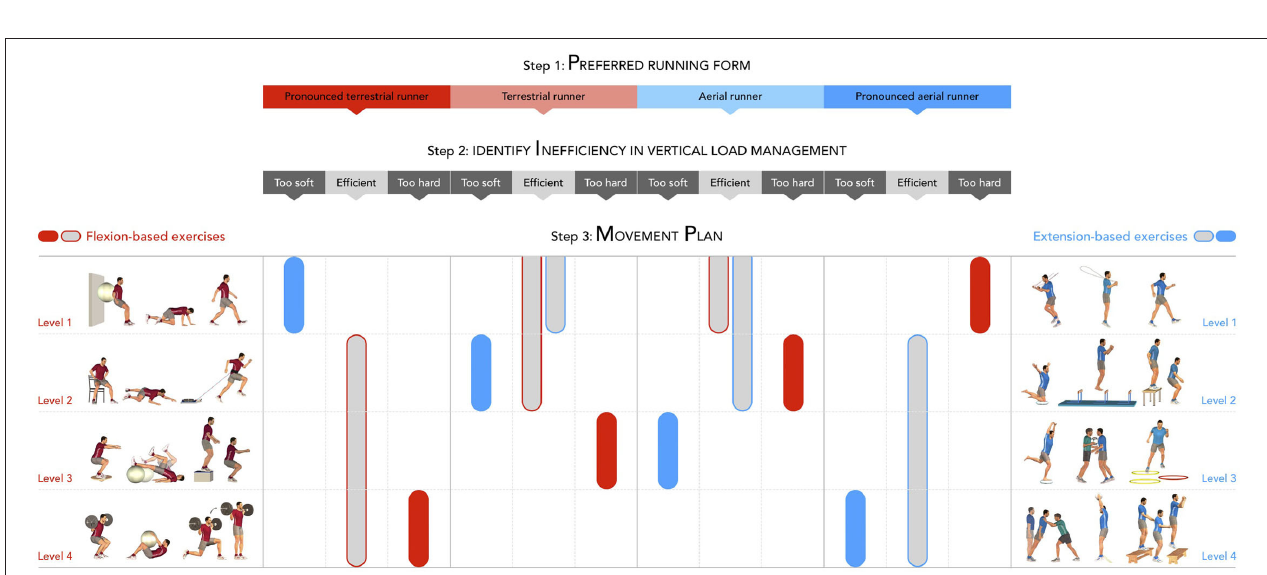
FIGURE 1 | Schematic illustration of the Volodalen ® method used to evaluate the runner’s running form and which attributes a global score ranging between 5 and 25 based on five criteria. Each of these five criteria is scored from 1 to 5. A global score smaller or equal to 15 indicates a terrestrial runner while a global score larger than 15 indicates an aerial runner. Illustration of posture and vertical ground reaction force during a running stride at 10km/h in a typical flexed terrestrial runner (left picture and red curve) and a typical extended aerial runner (right picture and blue curve).